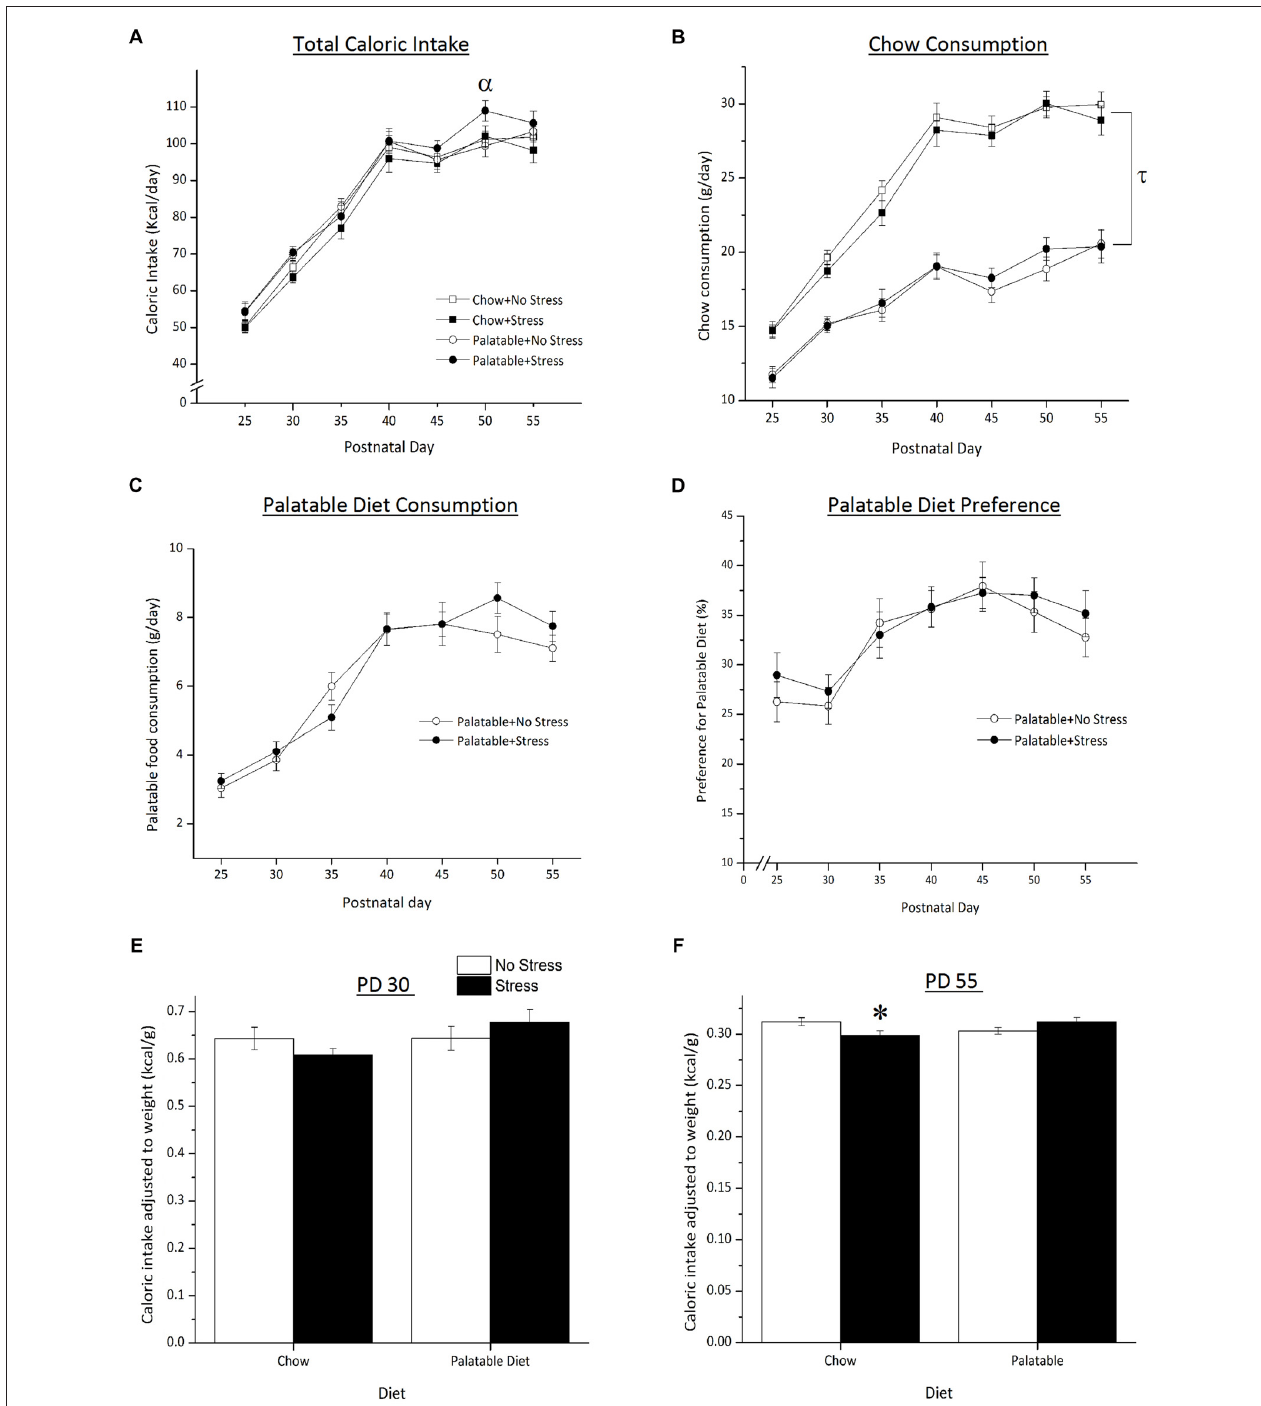
FIGURE 2 | Effect of access to a palatable diet and juvenile stressor exposure on total caloric intake, chow and palatable diet consumption and caloric intake (adjusted to body weight), palatable diet preference and weight gained. (A) Access to a palatable diet and juvenile stressor exposure increased total caloric intake on PD 50. (B) Access to a palatable diet led to an overall lower chow consumption across age. (C) Palatable diet consumption did not differ regardless of stressor exposure. (D) Across development, juvenile stressor exposure did not elicit a preference for a palatable diet. (E) Caloric intake did not differ on PD 30 between groups right after 3-day juvenile stressor exposure (PD 27–29). (F) Juvenile stressor exposure decreased caloric intake in late adolescence (PD 55) and this did not occur in rats that consumed the palatable diet. α Significantly different from non-stressed palatable diet fed group ( p < 0.05). τ Significantly different to chow diet groups ( p < 0.05). ∗ Significantly different from stressed palatable diet group and non-stressed chow group ( p < 0.05).